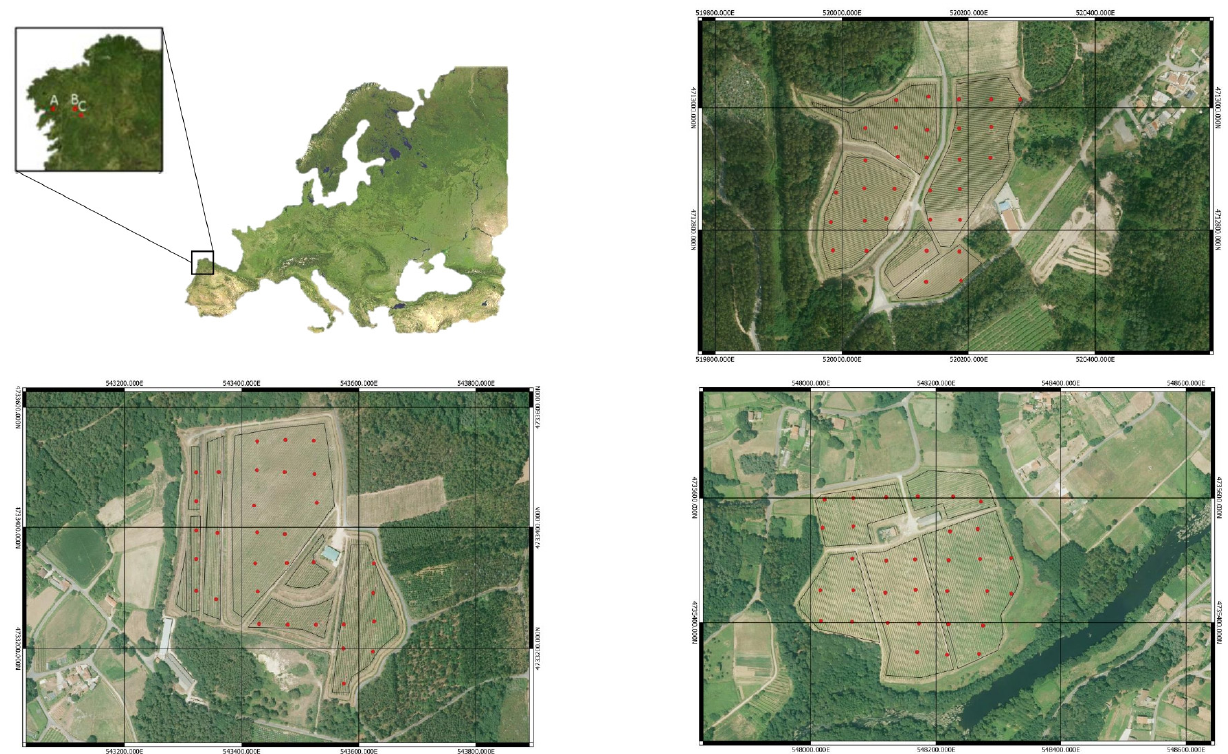
Figure 1. Study area locations—Galicia (Spain): ( A ) Lobeira (Vilagarcía de Arousa), ( B ) Monteveiga (Vedra) and ( C ) Ribadulla (Vedra). Soil sampling points are shown as red points.